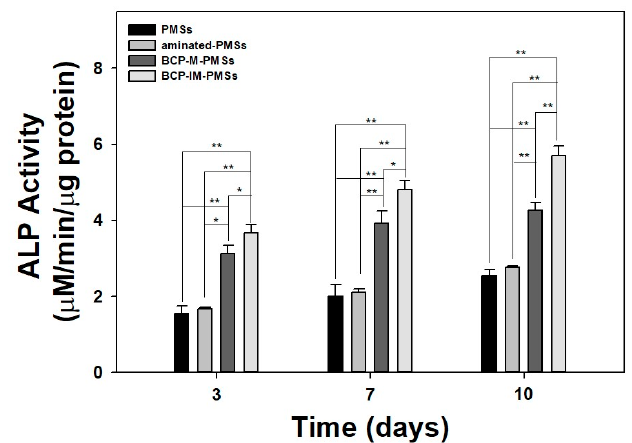
Figure 4. Alkaline phosphatase (ALP) activity of MG-63 cells cultivated on PMSs, aminated-PMSs, BCP-M-PMSs, or BCP-IM-PMSs after 3, 7, or 10 days of incubation ( n = 5) (* p < 0.05 and ** p <